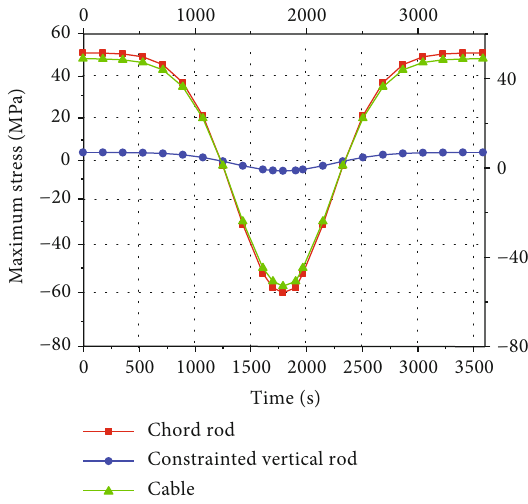
Figure 9: Time history of the maximum thermal